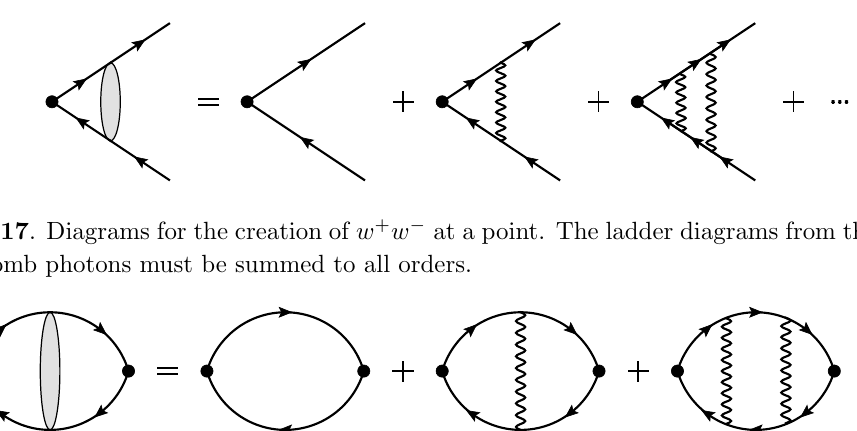
Figure 16 . Diagrams for w + w (cid:0) ! w + w (cid:0) with no zero-range interactions. A solid line with a forward arrow or a backward arrow represents a w + or a w (cid:0) , respectively. The ladder diagrams from the exchange of Coulomb photons must be summed to all orders.